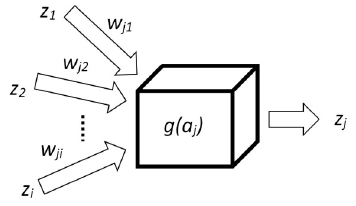
Figure 3. Mathematical model of a single neuron cell.